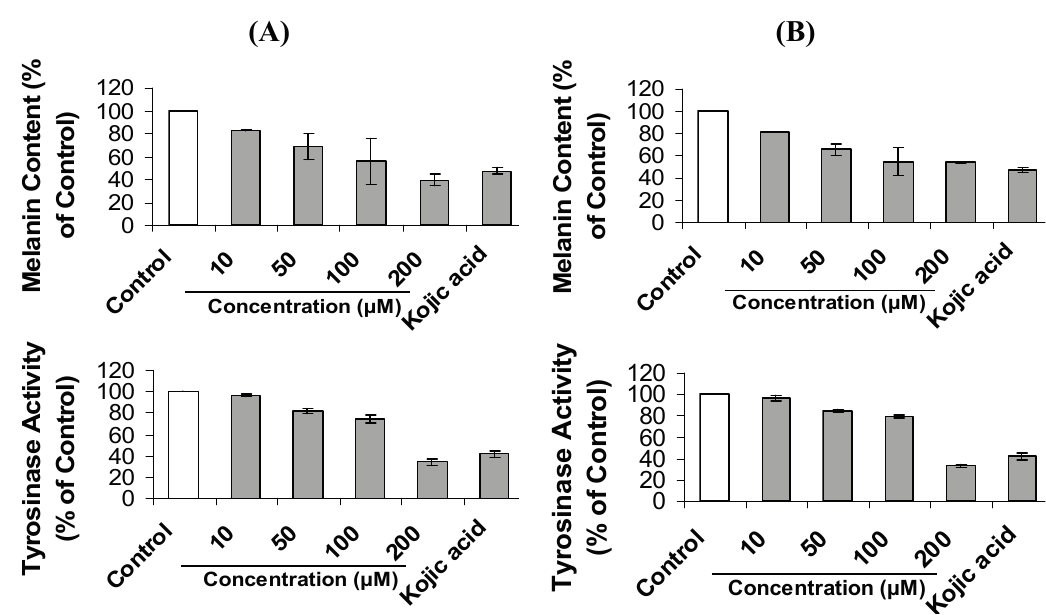
Figure 4. Reduction of the most potent dipeptides on melanin content and cellular tyrosinase in B16F10 cell. ( A ) Mi- D -Trp; ( B ) Mi- D -Val. Cells were treated with various concentrations of tested compounds for 48 h. Results are expressed as percentage in comparison with control. Kojic acid (500 μ M) was used as positive control. The experiments were conducted with three replications per each treatment with two independent experiments, and the values are means ± SE. Data have statistical significance at p ≤ 0.01. Table 3. IC 50 of mimosine dipeptides against intracellular tyrosinase and melanin content in B16F10 melanoma cells.